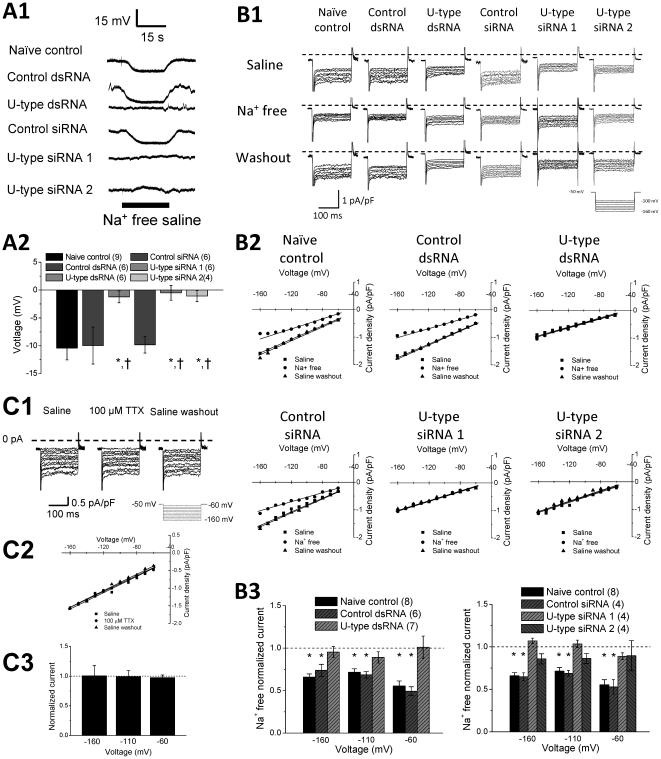
ILeak conducted by the U-type channel in RPeD1 cells is
carried by Na+ ions.(A1) Representative voltage traces of naïve control, control
dsRNA/siRNA, and U-type dsRNA/siRNA 1 & 2 with and without
Na+ free saline perfusion. (A2) Average voltage
difference between Na+ free perfusion and saline
perfusion for naïve control (n = 9), control
dsRNA (n = 6), U-type dsRNA
(n = 6), control siRNA
(n = 6), U-type siRNA 1
(n = 6), U-type siRNA 2
(n = 4). (B1) Representative ILeak in
RPeD1 cells from naïve control, control dsRNA/siRNA, and U-type
dsRNA/siRNA 1&2, at hyperpolarizing voltages in saline or
Na+ free solution (B2) Representative
ILeak density-voltage (I–V) relations of naïve
control, control dsRNA/siRNA, and U-type dsRNA/siRNA 1&2 in saline
or Na+ free solution. (B3) comparison of the average
normalized ILeak in Na+ free solution over
saline at −160 mV, −110 mV, and −60 mV for naïve
control (n = 8), control dsRNA
(n = 6), U-type dsRNA (n = 7),
control siRNA (n = 4), U-type siRNA 1
(n = 4), and U-type siRNA 2
(n = 4). A significant reduction in normalized
ILeak under Na+ free condition was
observed in RPeD1 cells from the naïve control and control
dsRNA/siRNA groups, but not from U-type dsRNA/siRNA groups. All
significant difference (P<0.05) between Na+ free
saline current normalized to saline is denoted by *. The dashed line
represents the current activity in saline. (C) Application of 100
µM TTX did not significantly affect Ileak. (C1)
Representative leak current traces of naive control neurons in saline,
100 µM TTX, and saline wash under a hyperpolarizing step voltage
protocol. (C2) Representative current-voltage relation for the leak
current observed in saline, 100 µM TTX, and saline wash. Line
represents a linear fit. (C3) Summary of relative current density of 100
µM TTX normalized to that in saline at various hyperpolarizing
voltages: −160 mV (n = 5), −110 mV
(n = 5) and −60 mV
(n = 5). No significant difference was observed in
the normalized currents among all the groups.